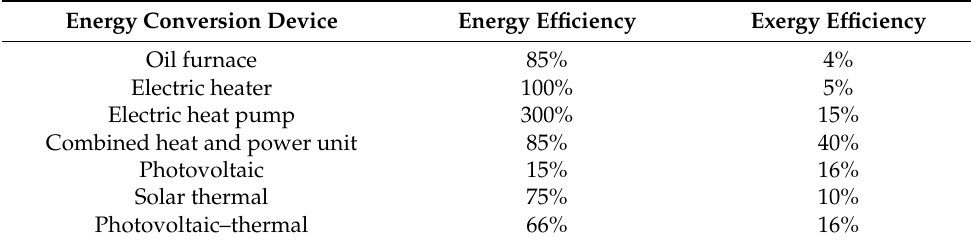
Table 1. Energy and exergy efficiency of different energy conversion devices